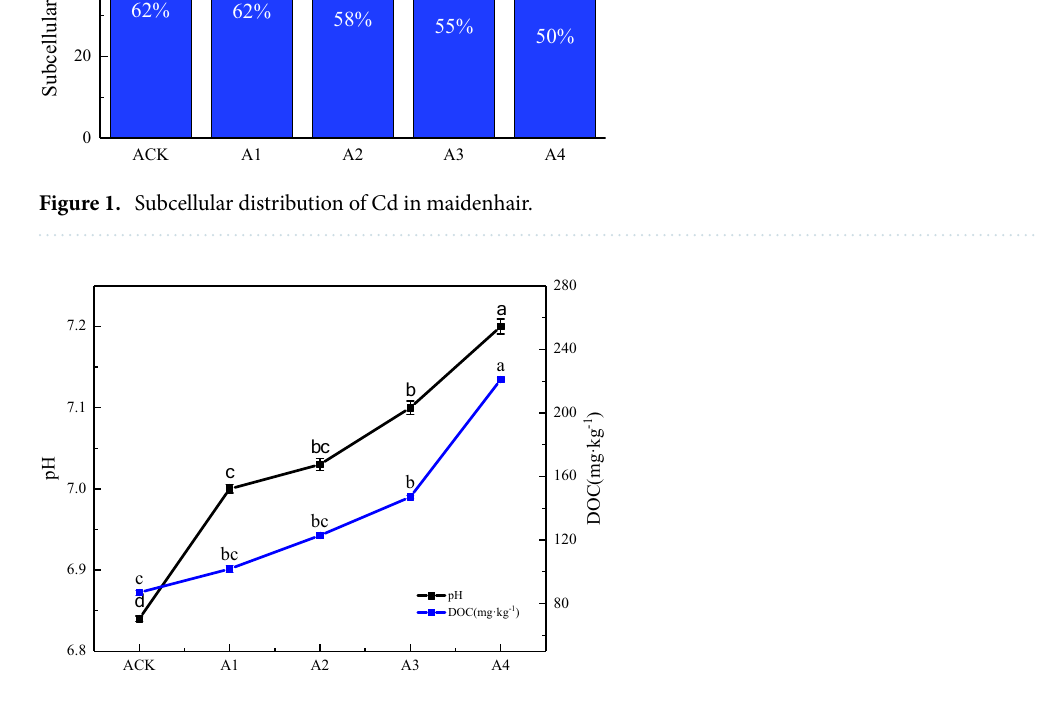
Figure 2. Soil pH and DOC in different GLDA